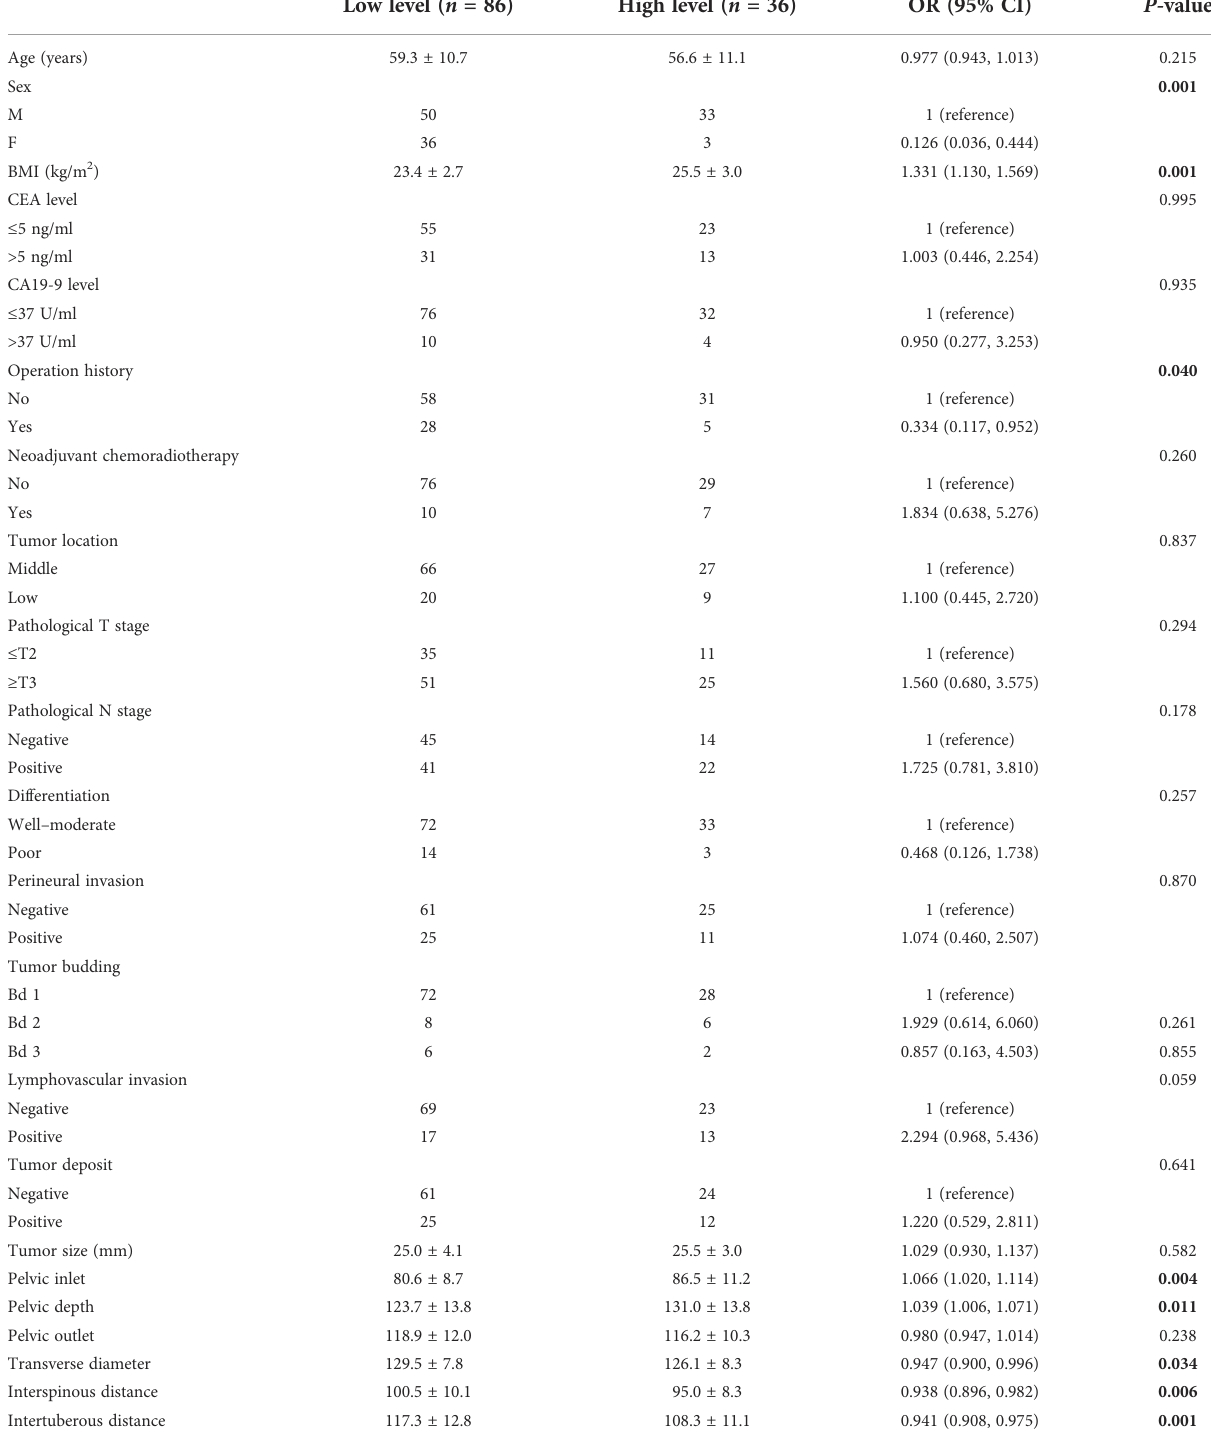
TABLE 4 Univariable logistic regression analyses of associations between factors and surgical dif fi culty